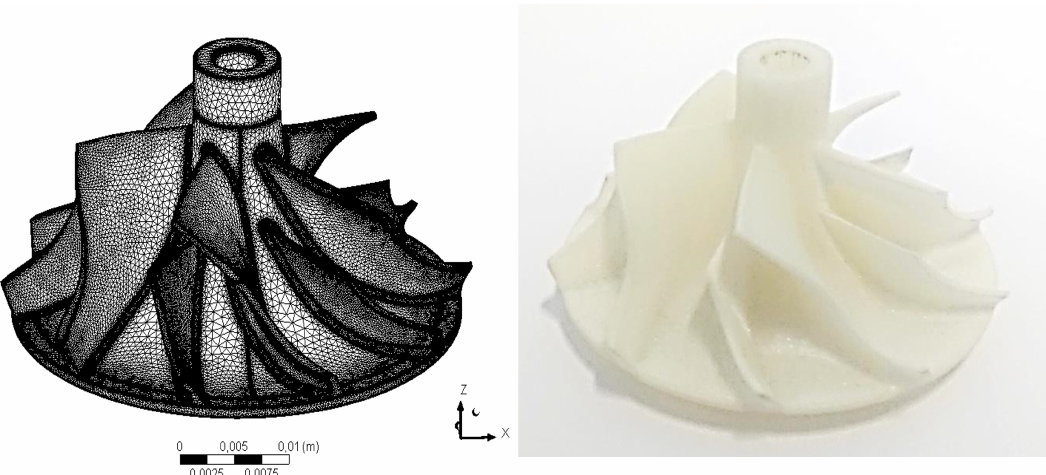
Figure 1. Model of compressor disc obtained by 3D scanning ( left ) and disc created using the MJ method ( right